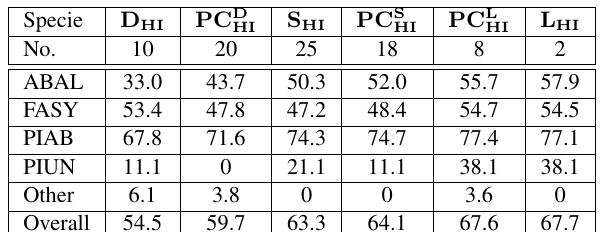
Table 5: F1-scores of feature fusion from the HI sets by stacking a number of features (No.) to the reference set D HI : 20 features from PC D , 25 features from S HI , 18 features from PC S HI features from PC L and 2 features from L HI . The last column HI